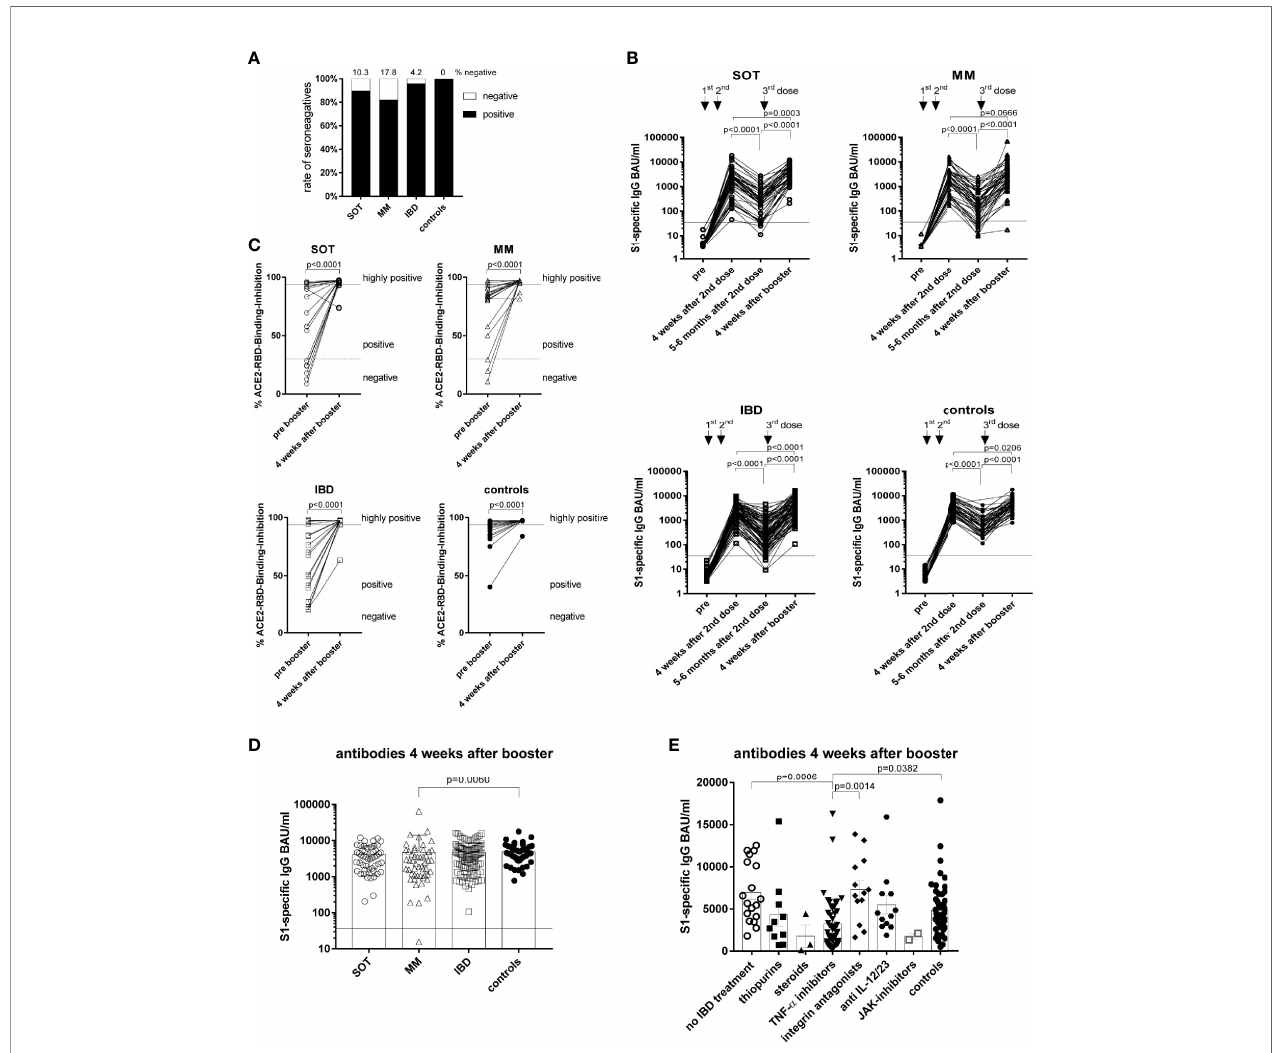
FIGURE 4 | Antibody responses over a six months period and to booster vaccination. The percentage of seronegative participants at fi ve-six months after the second dose (A) . Kinetics of antibody levels (B) , measured before the fi rst, four weeks as well as fi ve-six months after the second dose and four weeks after the booster dose for all study groups. Neutralizing antibody capacity before and after the booster dose in 20 randomly selected participants/group (C) . Differences in individual S1-speci fi c IgG levels between the study groups (D) . S1-speci fi c IgG levels of IBD patients in respect of their treatment and in comparison to the controls (E) . SOT (n=58) are represented as open circles, MM (n=56) as open triangles, IBD (n=114) patients as open squares and controls (n=62) as full circles. Differences between the groups below p values of 0.05 were regarded as signi fi cant. Black lines represent the threshold for positive results (35.2 BAU/ml) (A-B, D). Dotted lines represent cut-off for positive values and black lines the cut-off for highly positive values in the surrogate neutralization test (C) . Columns represent GMC with 95% con fi dence interval (CI) (D)